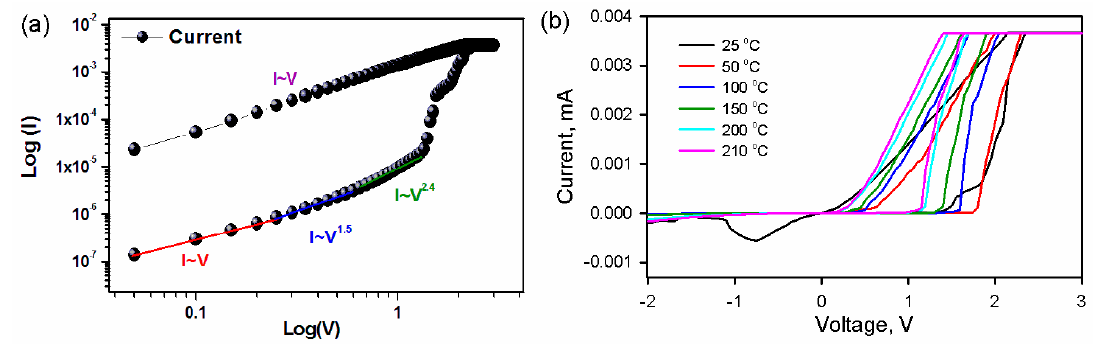
Figure 5. ( a ) The logarithmic I-V curve in the positive bias region and ( b ) temperature-dependent current–voltage characteristics of a multilayer Ag / CuO / SiO 2 / p-Si. Device temperature was varied from 25 °C to 210 °C.